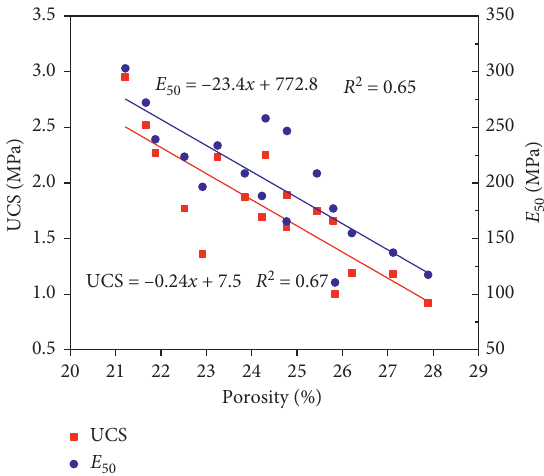
Figure 6: Relationships between porosity and of UCS and